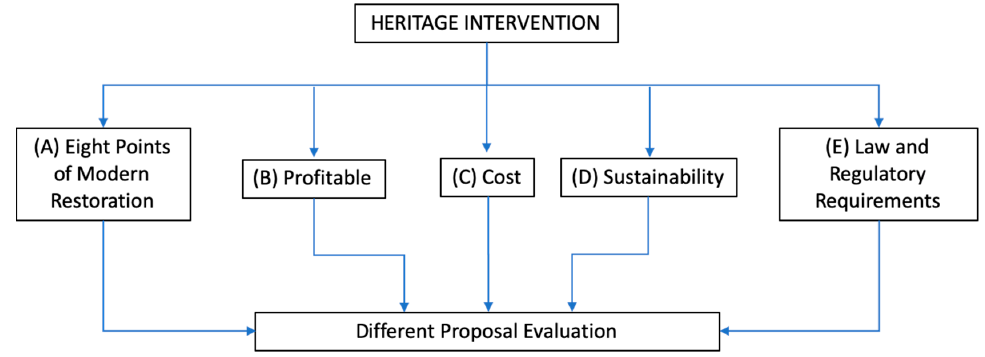
Figure 4. Proposal evaluation criteria.